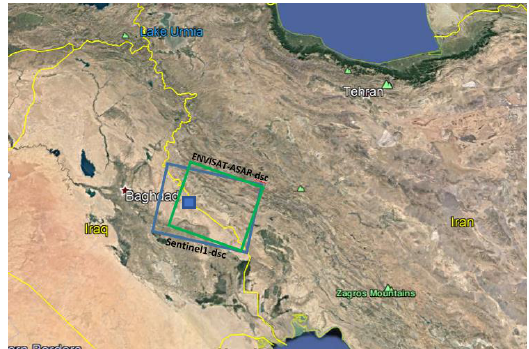
Figure 5. Topography map of Mehran, Ilam. The boxes show satellite trajectories of radar images for descending orbits. The blue box is Azar Oil Field